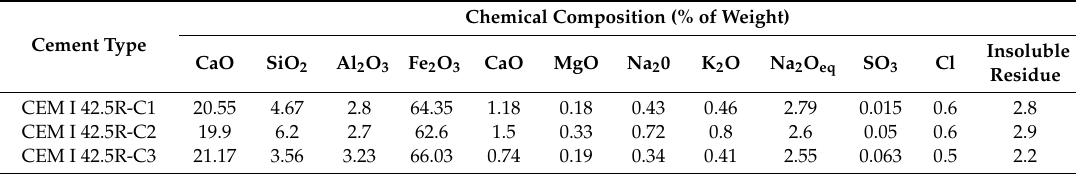
Table 1. Chemical composition of types of cement used in the research.